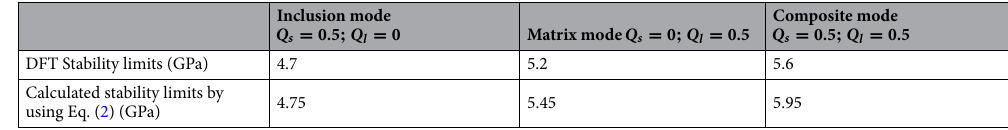
Inclusion mode Q s = 0.5 ; Q l =